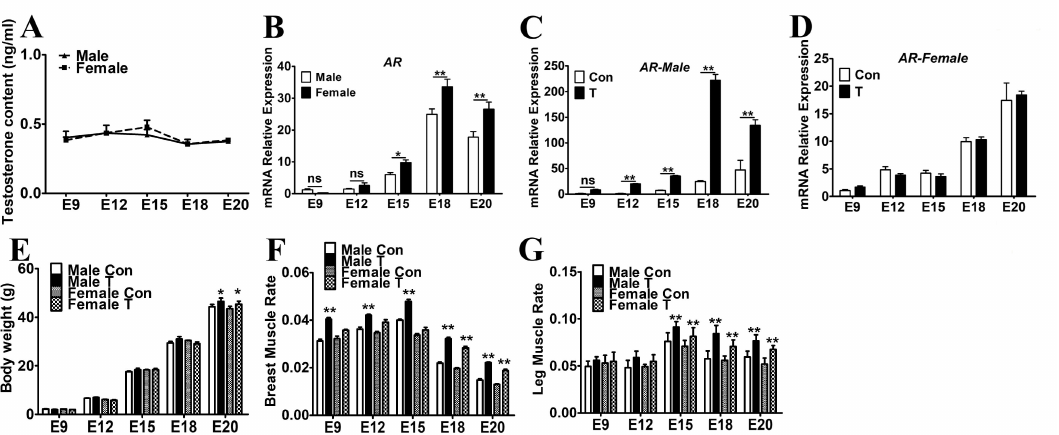
Figure 1. The measurement of T level, muscle mass and AR expression. ( A ): The content of endogenous T in embryonic chickens. ( B ): AR mRNA expression in embryonic chickens. AR mRNA expression in male ( C ) and female ( D ) chicken embryos after injection of T. The body weight ( E ), the ratio of breast muscles ( F ) and leg muscles ( G ) in embryonic chickens with or without T treatment. Data are presented as the means + SE. Asterisk (*) represents statistically di ff erent ( p < 0.05). p < 0.01 is shown as **. n =